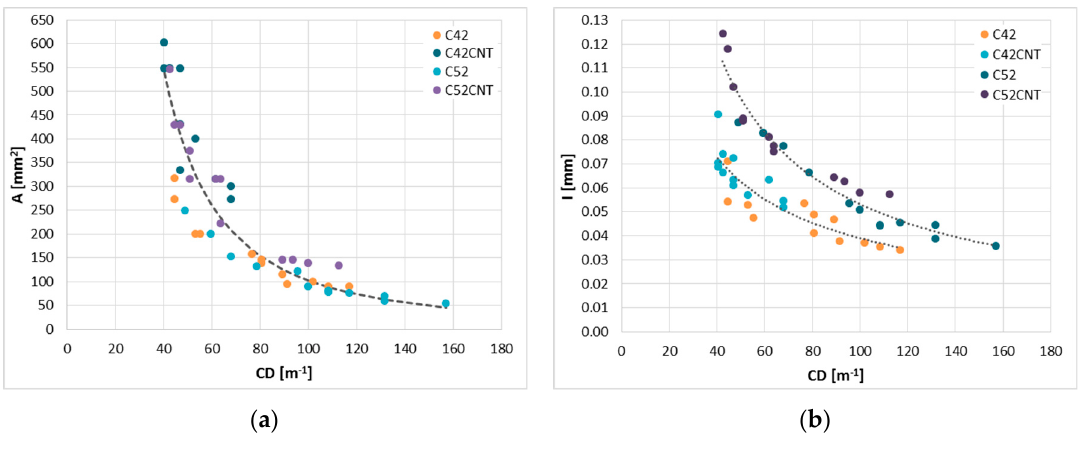
Figure 9. Relationships between parameters of the cracking patterns: ( a ) 𝐴̅(𝐶𝐷) ; ( b ) 𝐼̅(𝐶𝐷) . Table 5. Equations of the functional curves describing the A ( CD ) and I ( CD ) relationship; R 2 , S e , W—diagnostic statistics; ρ —correlation coe ffi cient.